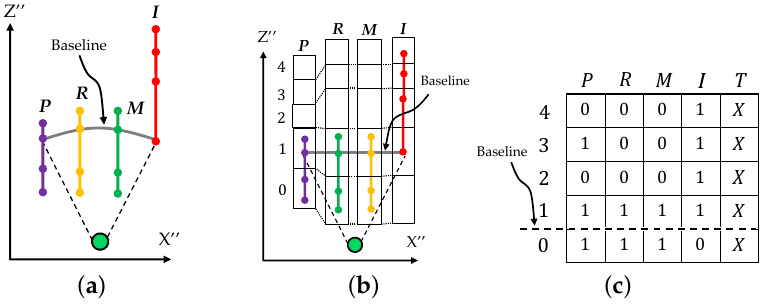
Figure 16. Template matching: ( a ) Hand skeleton projection, ( b ) Template matching and ( c ) Matrix of binary